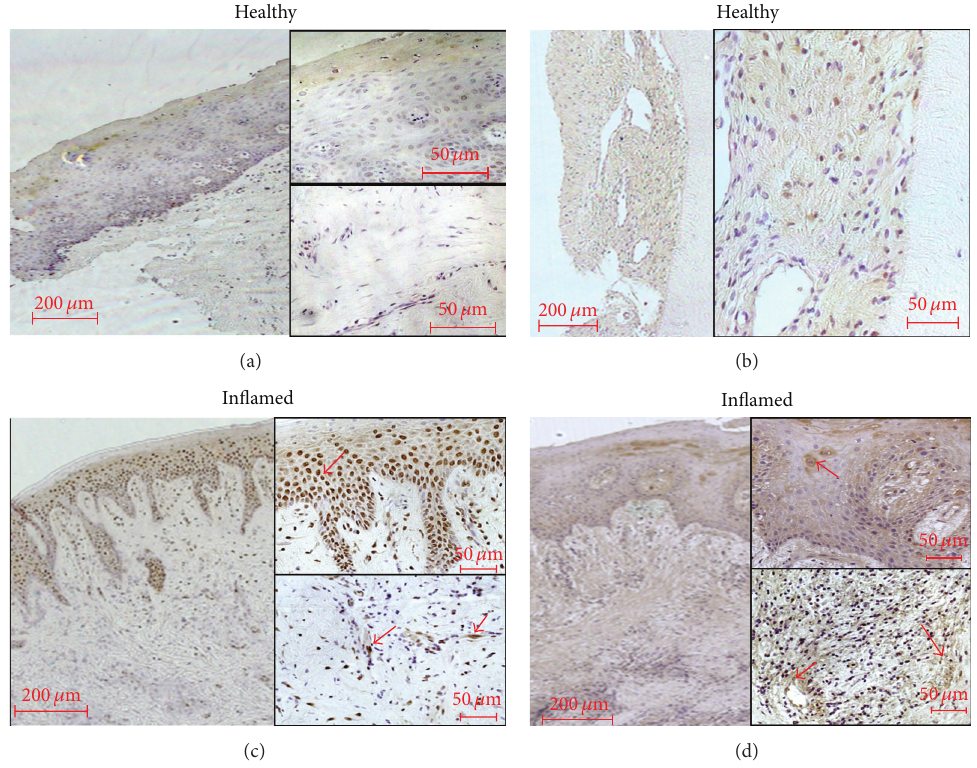
Figure 4: NADPH-oxidase 4 (NOX4) occurrence in healthy and inflamed human tissue. Healthy gingival epithelium (a), periodontal ligament (b), and samples of gingivitis (c) or periodontitis (d) were obtained after the approval of the Ethics Committee of the University of Bonn and parental as well as patient’s allowance ( 𝑛 = 3 ). Monoclonal primary antibody against NOX4 (Abcam, Cambridge, UK) was used in a concentration of 1: 100. In gingival and PDL fibroblasts as well as in immune cells like leukocytes and in vessels, the immunoreactivity was primarily restricted to the cytosol and cell walls. Red arrows indicate examples for the typical distribution (Figures 4(c) and 4(d)). The scale bars indicate 200 𝜇 m in the surveys and 50 𝜇 m in the higher magnifications,